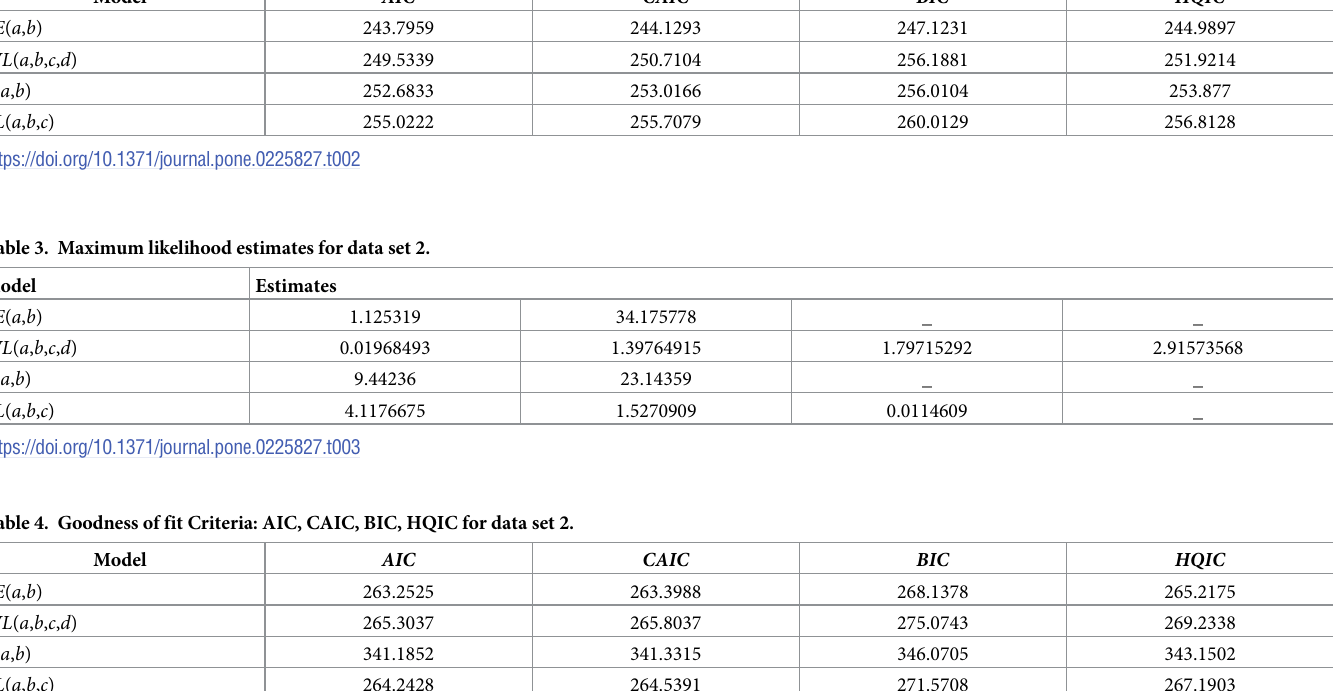
Table 2. Goodness of fit Criteria: AIC, CAIC, BIC, HQIC for Data set 1. Model